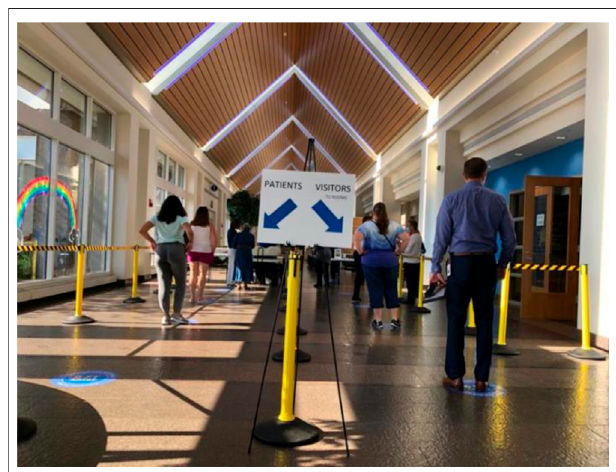
FIGURE 6 | Waiting line: Hospital in Carmel, Indiana (2019), photograph by Lisann Good-Burton.